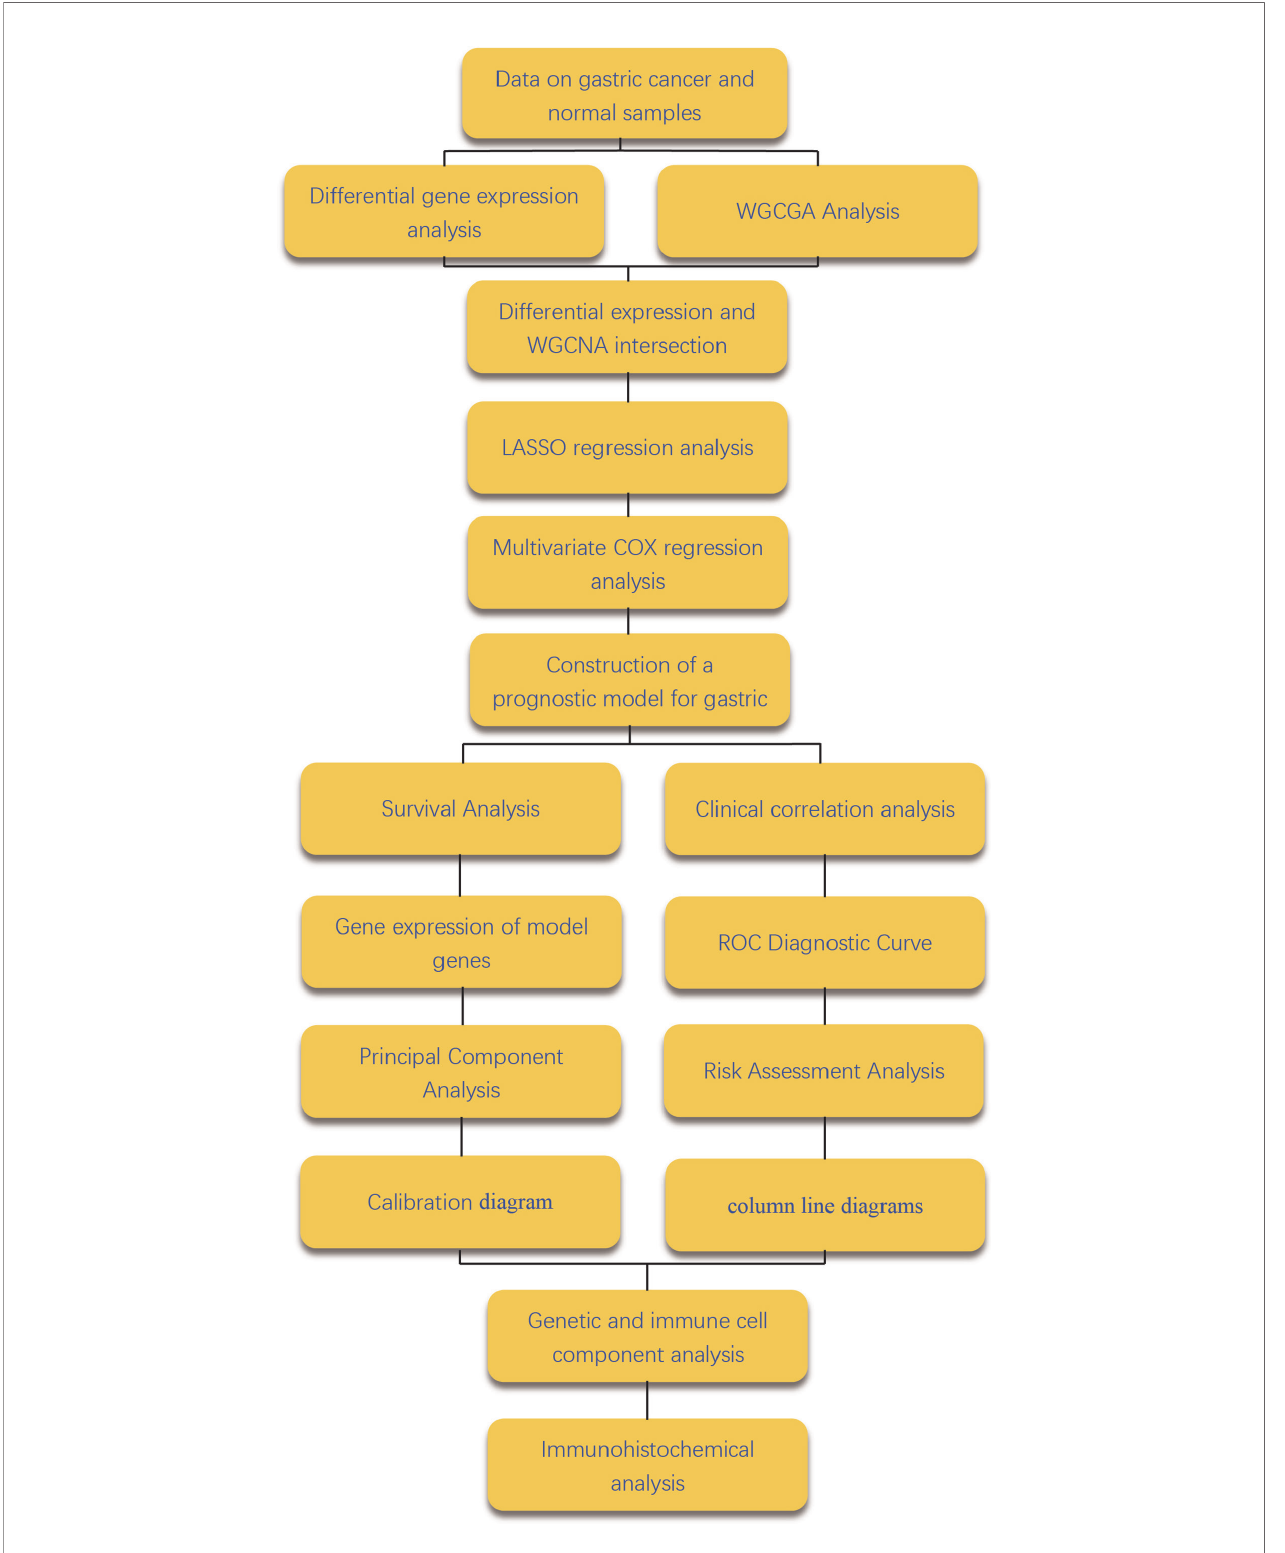
FIGURE 1 | Work fl ow diagram. Figure 1 shows the fl ow of the work done in this study is shown in the fi gure.